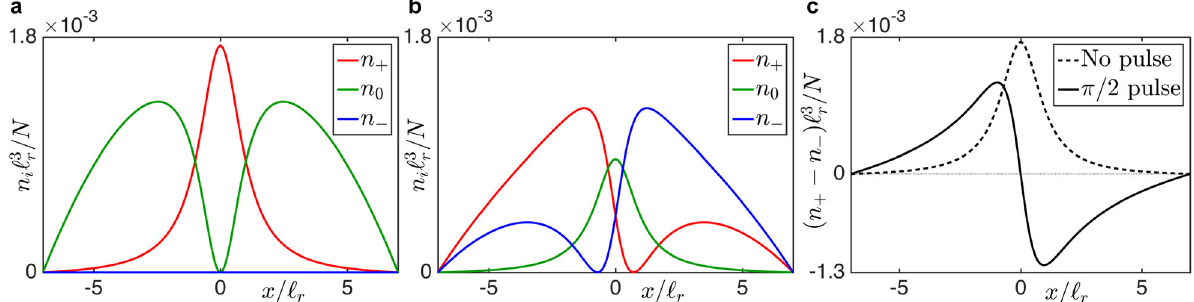
Fig. 2 Theoretical illustrations of the vortex-core structure and order parameter. a Two polar singly-quantized vortices (SQVs) corresponding to Fig. 1c. The background indicates condensate spin magnitude, showing the ferromagnetic cores. The symmetry of the order parameter is represented as the P þ 1 Y ð θ ; ϕ Þ ζ surface of ∣ Z ( θ , ϕ ) ∣ 2 , where Z ð θ ; ϕ Þ ¼ m expands the spinor in terms of the spherical harmonics m ¼(cid:2) 1 1 ; m spherical coordinates ( θ , ϕ ). The color map shows Arg ð Z Þ and the upper grayscale bar indicates the spin magnitude. b The corresponding spinor components, with density as indicated by the lower grayscale bar. c , d Same as ( a , b ), but after application of a π /2 spinor rotation. e , f Expanded view of a single SQV after time evolution, corresponding to the experimental situation in Fig. 4a. The SQV has split into a pair of half-quantum vortices (HQVs). Orange solid (dashed) circles indicate the positions of the SQVs (HQVs).